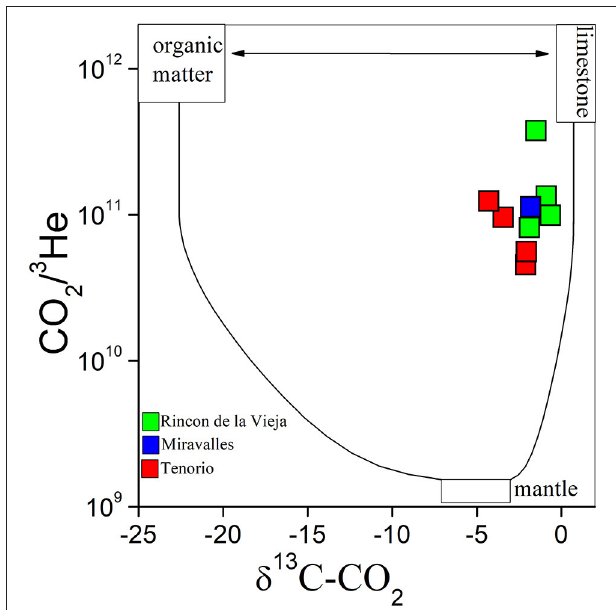
FIGURE 2 | CO 2 / 3 He vs. δ 13 C-CO 2 binary diagram. End-member compositions of organic matter, limestone and mantle are from Sano and Marty (1995) . Mixing curves between the three end-members are reported. Symbols as in Figure 1 .